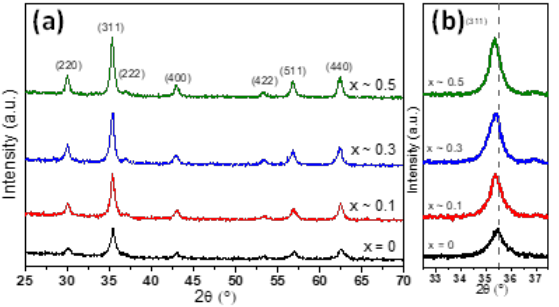
Figure 2. ( a ) XRD diffraction patterns and ( b ) zooms in the (311) diffraction peak region of Zn x Fe 3−x O 4 MNPs with different stoichiometry (0 ≤ x < 0.5).